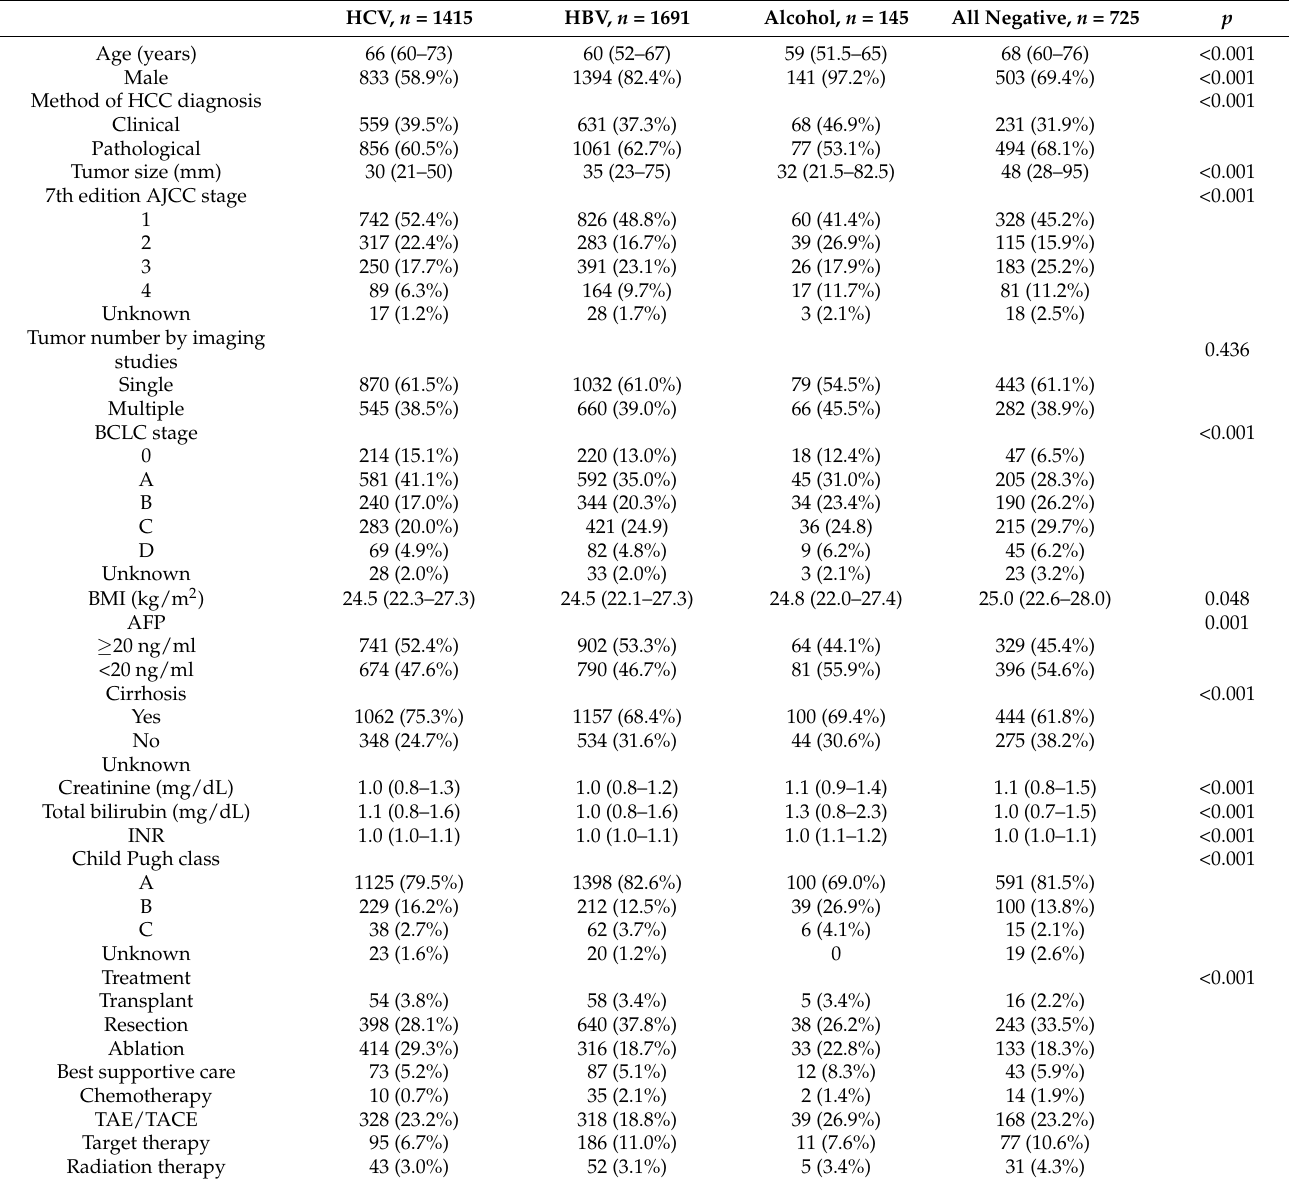
Table 1. Characteristics of patients according to etiologies of chronic liver